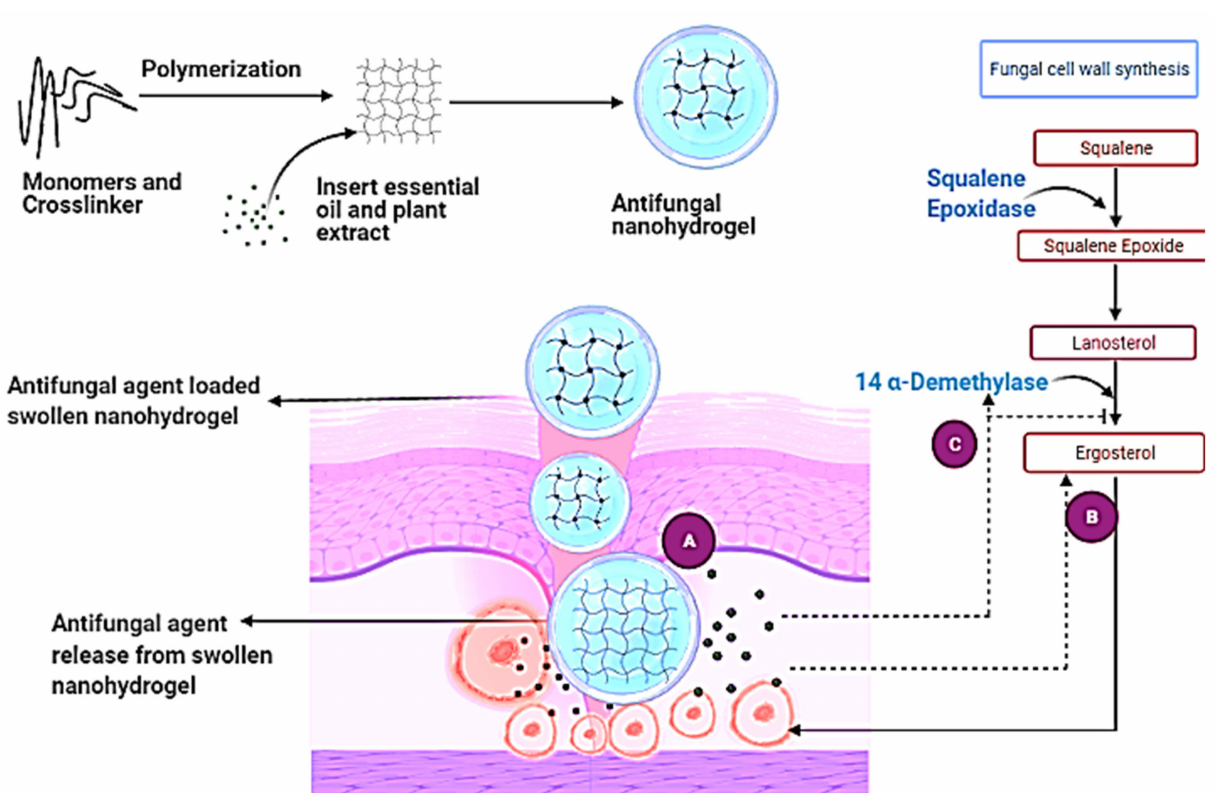
Figure 3. Mechanism action of nanohydrogel and antifungal components. A: Swollen nanohydrogel contacts stimuli in the environment and releases antifungal agents by following three mechanisms; B: antifungal agent binds to a vital component of the fungus cell wall, create spores, and leads to the death of the cell or causes respiration inhibition of the fungus cell; C: antifungal agent interferes with the catalyst and inhibits the ergosterol synthesis from lanosterol, causing cell